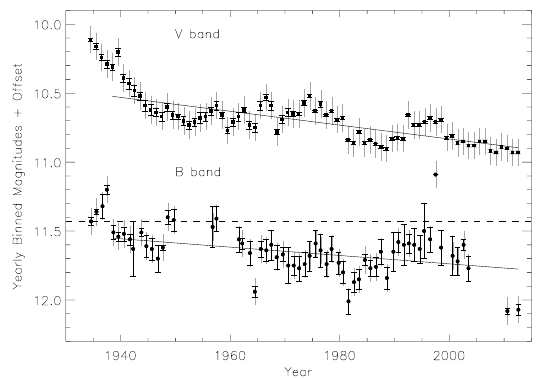
Figure 2: This yearly binned light curve for V603 Aquilae (Nova Aquilae 1918) clearly shows a secular fading in both B − and V -band, as predicted by the hi- bernation model. The calculated decline rate for V603 Aql is 0 . 44 ± 0 . 04 mags per century. Figure reproduced with permission from Johnson et al.